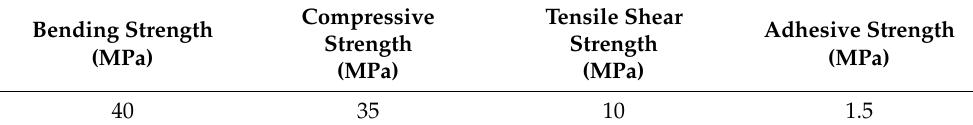
Table 4. Material properties of epoxy resin.